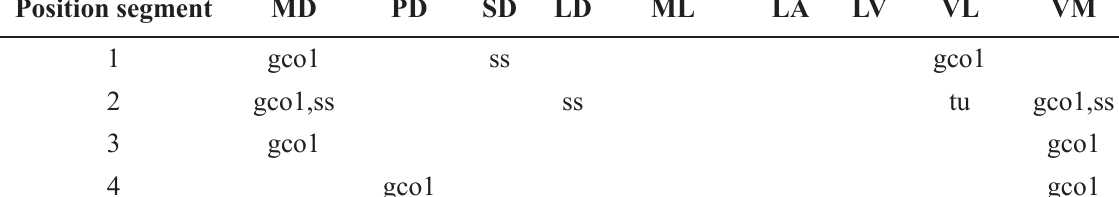
Table 11. Summary of nature and location of sensory spots, glandular cell outlets, tubes and spines arranged by series in Echinoderes gandalfi sp.